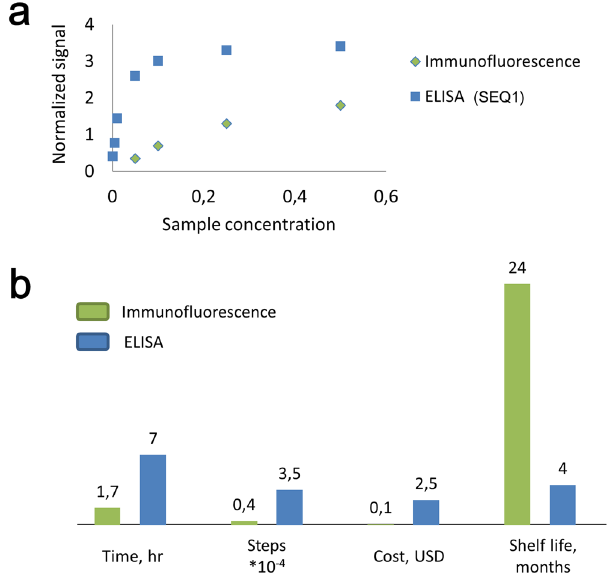
Figure 5. Comparison of SEQ1-ELISA and immunofluorescence assays: ( a ) limit of target detection determination. Signal at each point is a mean value for triplicate measurement of randomly selected 5 SLE samples; ( b ) ( left to right ) time, step count per one assay; cost per sample analysed, shelf-life time of antigen. Each measurement has been done three times with a result deviation ±